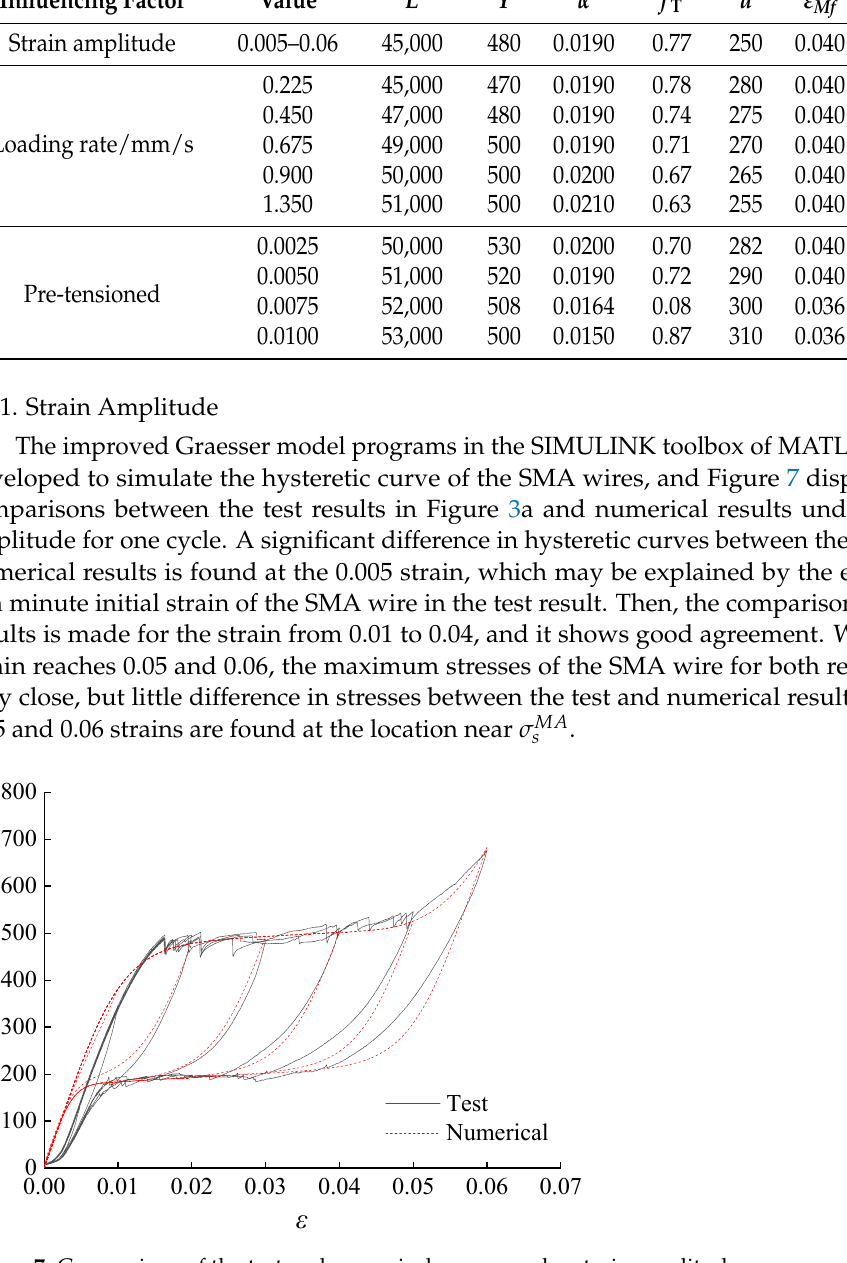
Figure 7. Comparison of the test and numerical curves under strain